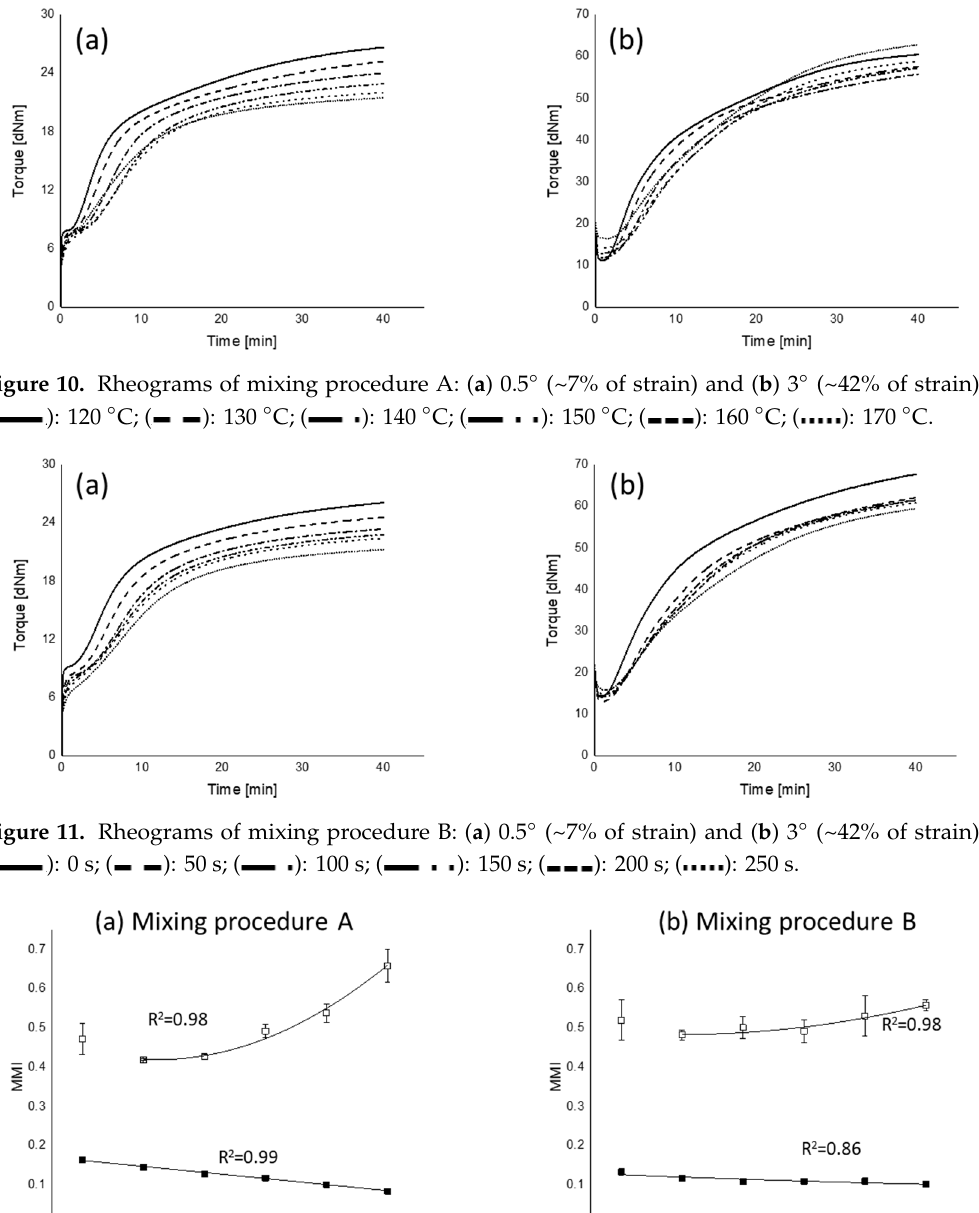
Figure 2. Mixing fingerprints of mixing procedure B; (